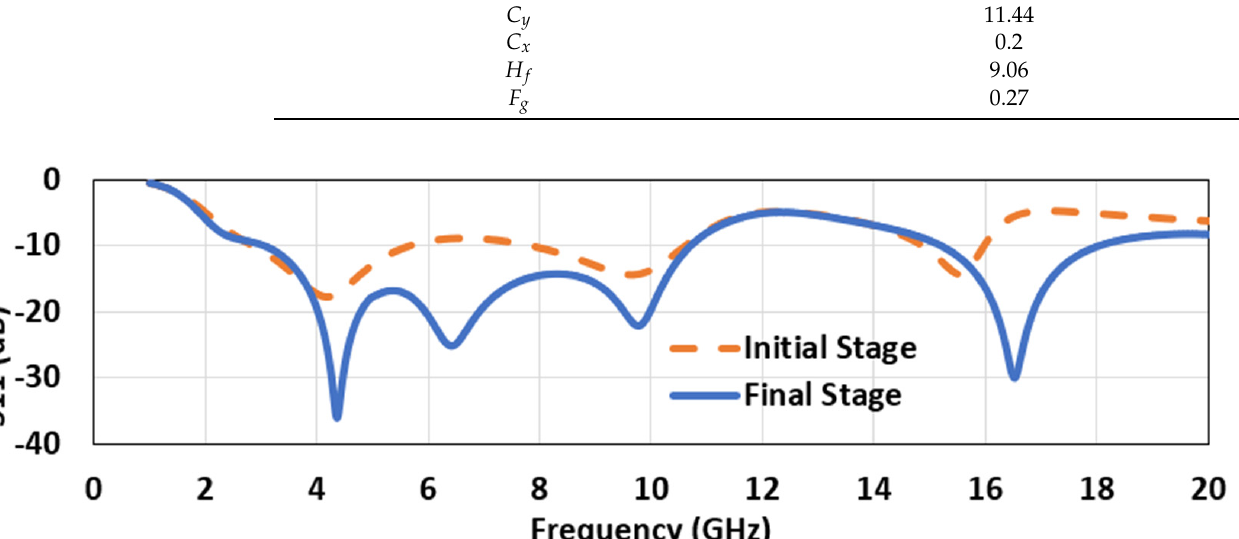
Figure 2. The reflection coefficient plot of the antenna’s design stages. Table 2 . The proposed free-space antenna dimensions .